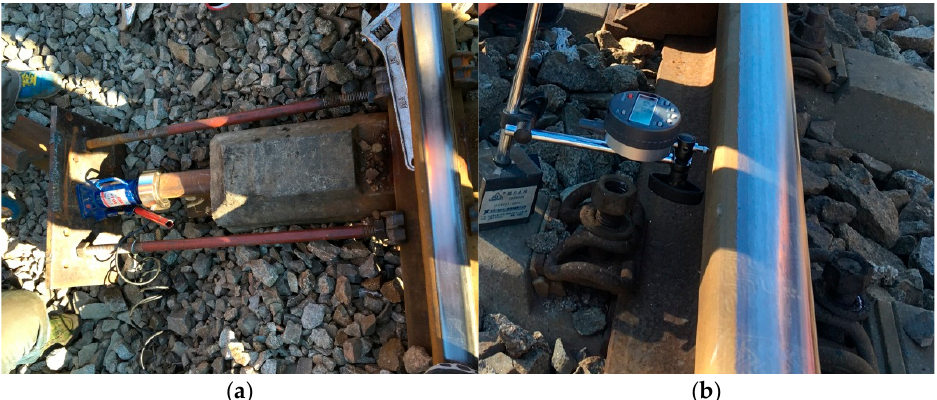
Figure 4. Field tests of lateral ballast resistance. ( a ) Forcing device; ( b ) Displacement measured by a dial gauge.